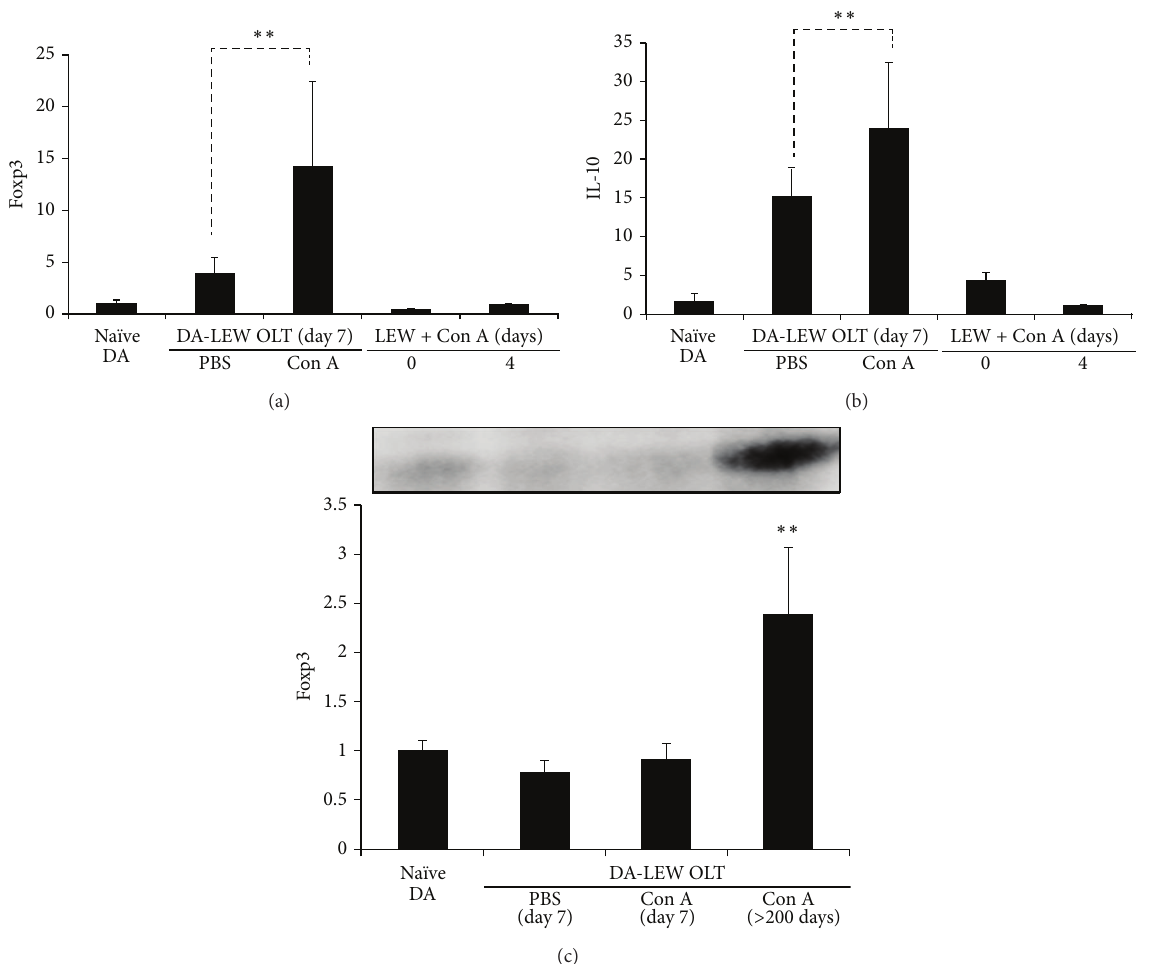
Figure 5: Hepatic levels of Foxp3 (a) and IL-10 (b) during the rejection phase after OLT or in the course of Con A-induced autoimmune hepatitis. The results are expressed as the mean of five individuals ± SD. ∗∗ Significantly different compared with the control PBS group ( 𝑛 = 5 ) ( 𝑃 < 0.01 , Student’s t -test). (c) Protein level of Foxp3 in na¨ıve and OLT livers at rejection (day 7) or acceptance ( > 200 days) was semiquantified by Western blot. Results are expressed as the mean of three independent experiments (ratio to na¨ıve DA) ± SD. ∗ Significantly different compared with na¨ıve DA livers ( 𝑃 < 0.01